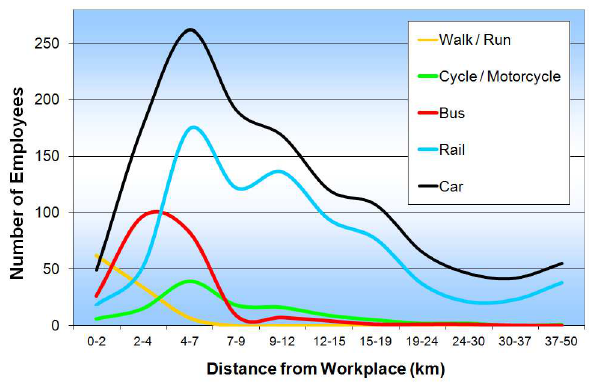
Figure 6. Employee Mode of Transport by Distance Travelled